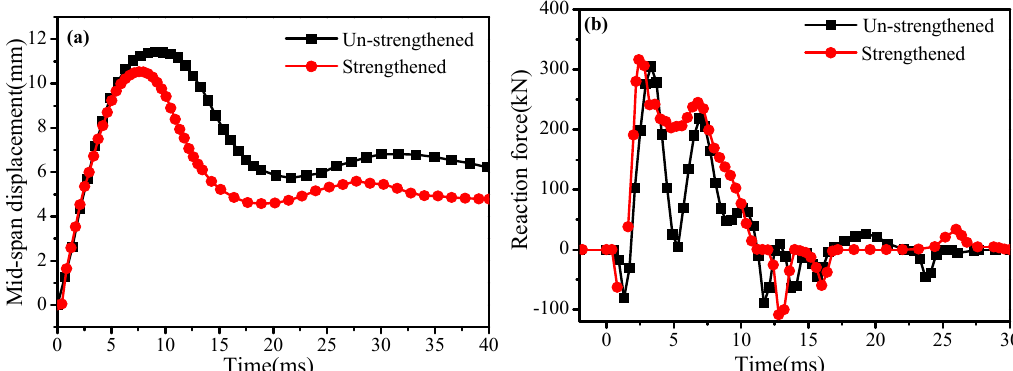
Figure 10. Time histories of T-beam with and without CFRP. ( a ) Mid-span displacement. ( b ) Reaction force. Crystals 2020 , 10 , x FOR PEER REVIEW